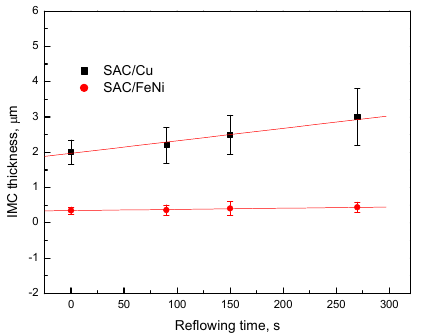
Figure 5. Dependence of the thicknesses for IMC layers on the reflow time.